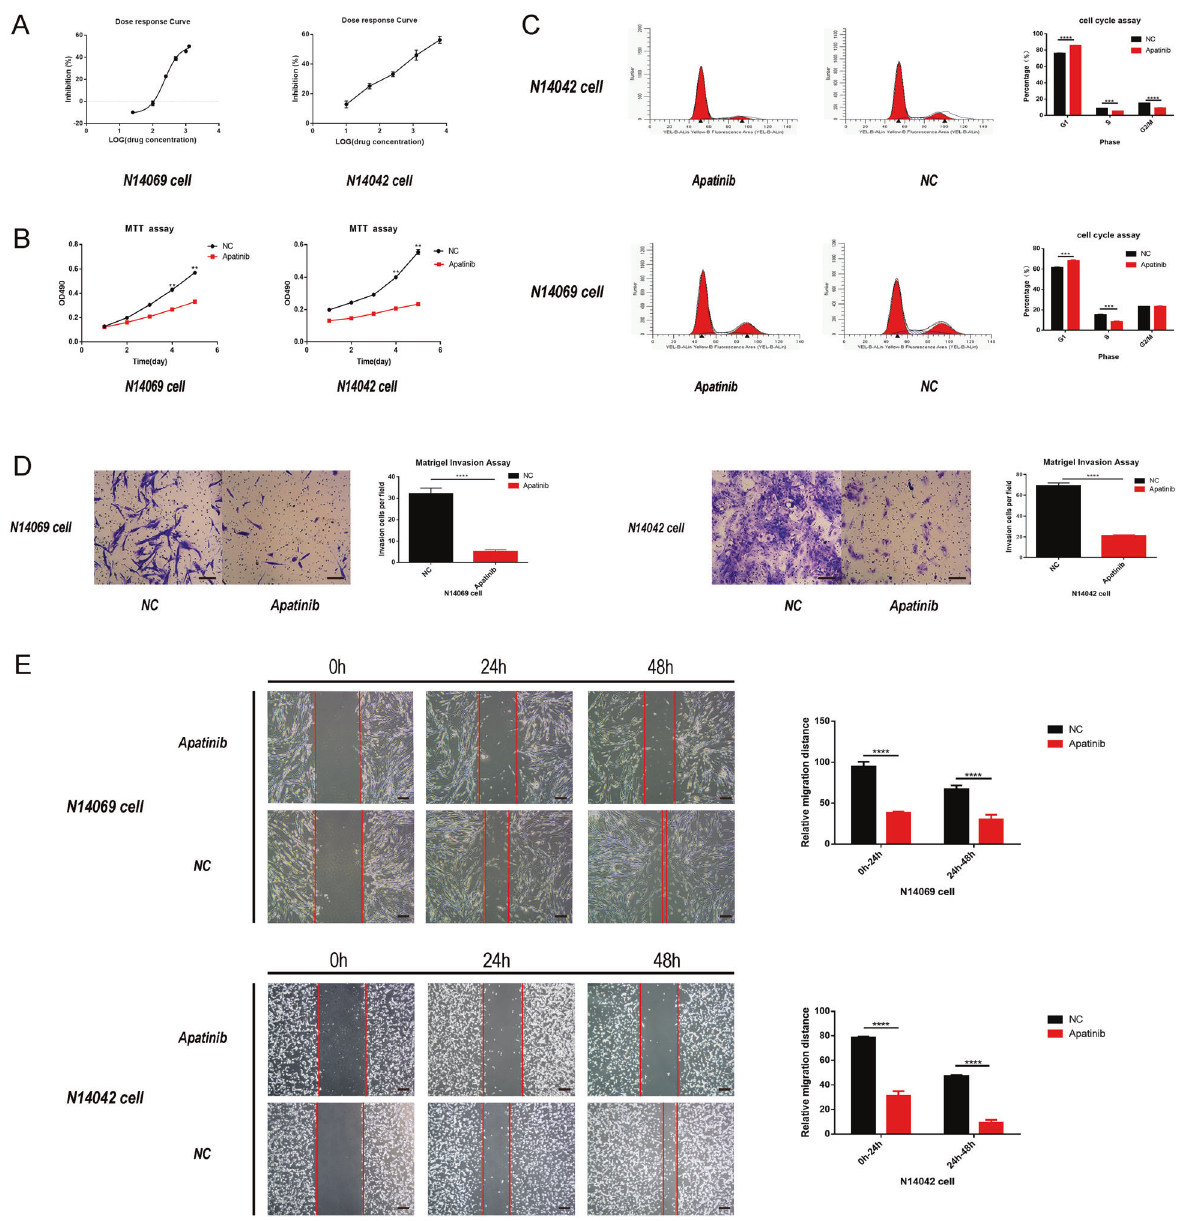
Fig. 2 Apatinib inhibits the proliferation and invasion of glioma cells in vitro. A Half-maximum inhibitory concentration (IC 50 ) of two human glioma cell lines: N14042 cells (292.9 µmmol/L) and N14069 cells (231.6 µmol/L). B Representative proliferation curves showed that proliferation of glioma cells was signi fi cantly inhibited by apatinib treatment (at IC 50 ). C Representative fl ow cytometry pro fi les and corresponding histograms showed that the cell cycle of glioma cells was signi fi cantly blocked by apatinib treatment (at IC 50 ). D , E Representative images and corresponding histograms of glioma cell numbers and diameters showed that the invasion and migration ability of glioma cells was signi fi cantly inhibited by apatinib treatment (concentration within 5% of the lethal dose; E : ×40 magni fi cation, D : ×100 magni fi cation). Data are shown as mean ±standard deviation (SD), n = 3, * p <0.05, ** p <0.01, *** p <0.001, **** p <0.0001, Student ’ s t